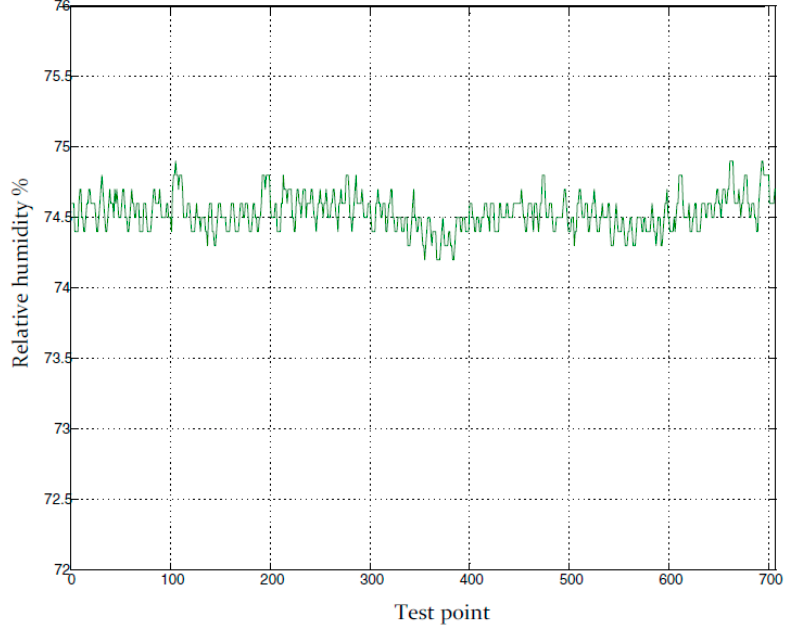
Figure 11. The relative humidity under closed loop control with temperature fluctuation ±0.05 °C.